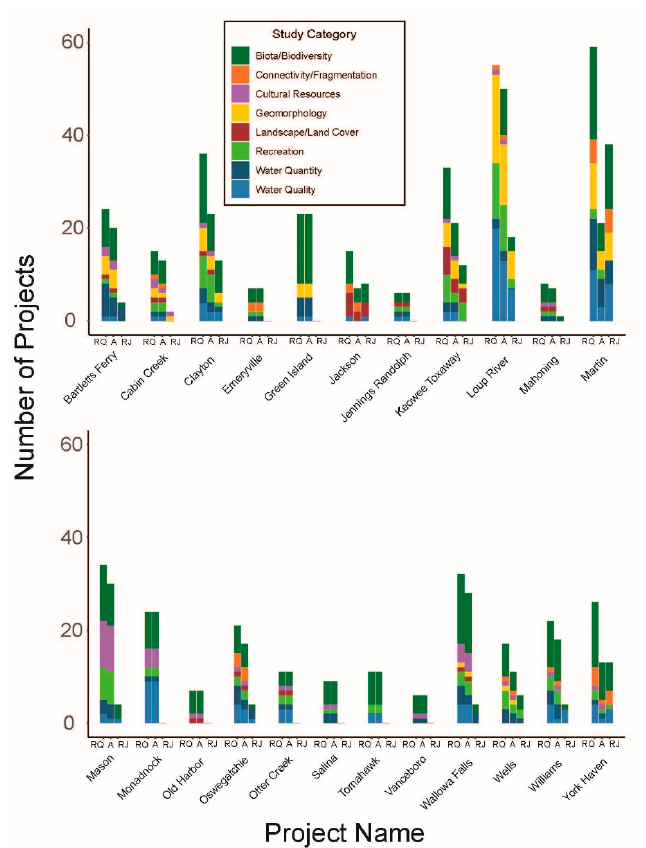
Figure 4. The number of requested, approved, or rejected studies by study category for the 23 projects in dataset 1, analyzed with study determination letters.